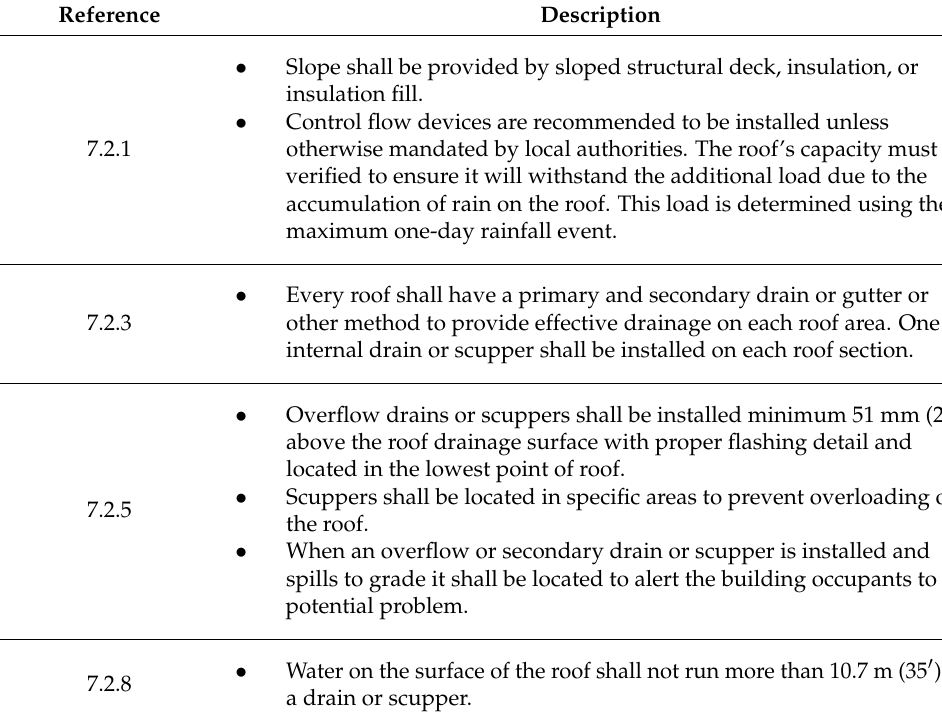
Table 2. Roof drainage requirements as in CSA A123.26